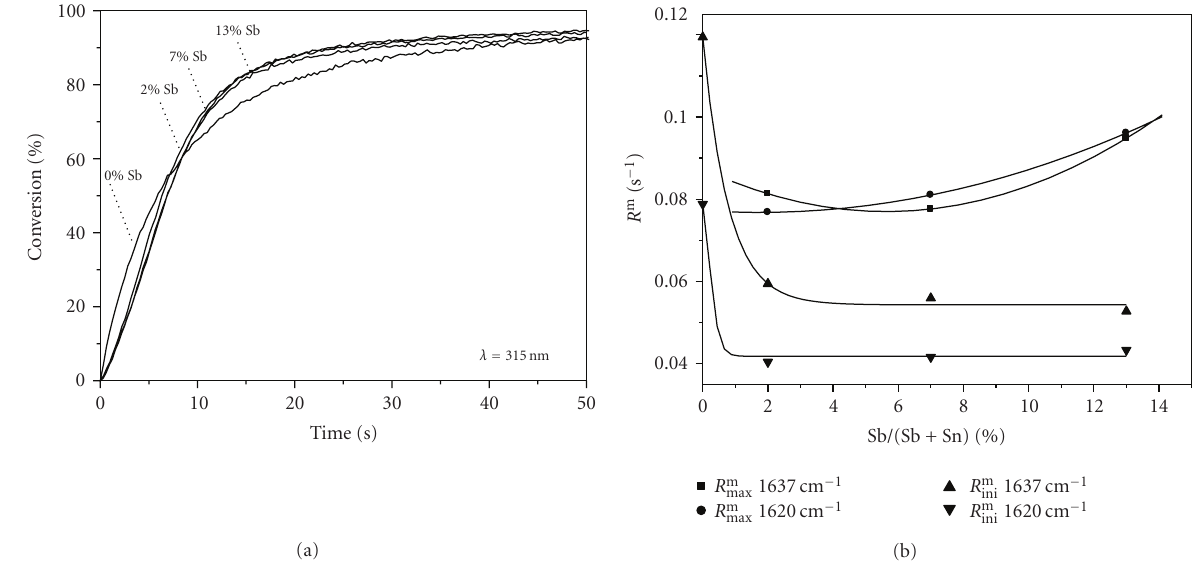
Figure 8: Dependency of the photocatalysed C = C bond conversion on the Sb doping level of the Sb:SnO 2 particles (10vol.% Sb:SnO 2 , 0% ≤ Sb ≤ 13%; MPS / Sb : SnO 2 = 0 . 19g/g). (a) Relative C = C bond conversions over time measured at 1637 cm − 1 . (b) The R m measured as a function of Sb/(Sb + Sn) at 1637 and 1620 cm − 1 di ff erent wave